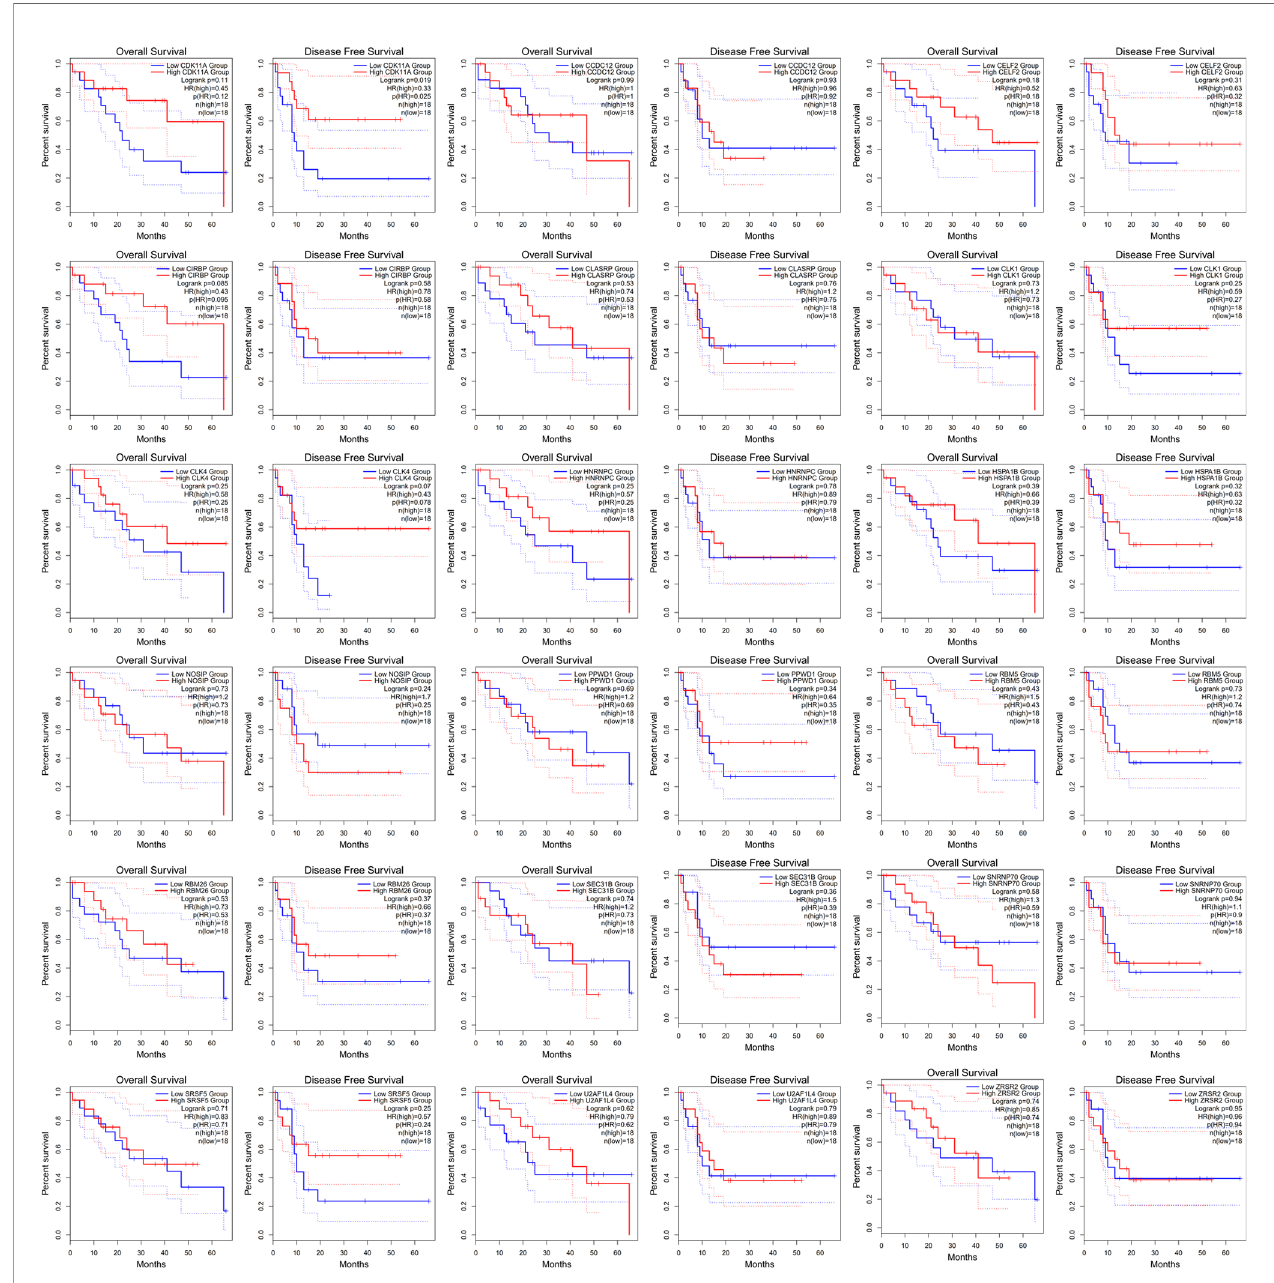
FIGURE 8 | The receiver operating characteristic curve of alternative splicing (AS) signature related splicing factors in overall survival and disease-free survival in patients with